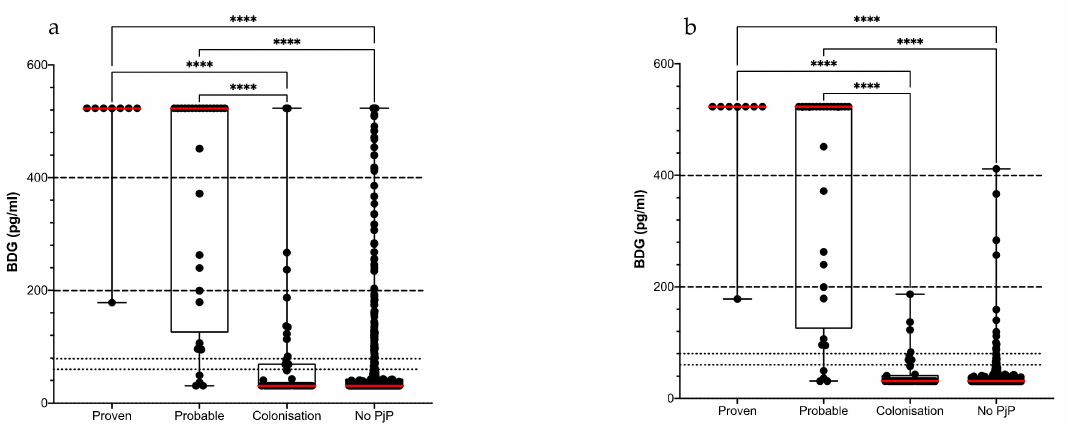
Figure 3. BDG value in 609 episodes from 575 HIV-negative patients suspected of PjP according to the final diagnosis retained. BDG values ( a ) with and ( b ) without evident cases of BDG false positive results. Comparison of the four groups was done using Kruskal-Wallis tests followed by Dunn’s pair-wise comparisons. p -adjusted values are indicated. Red line: median BDG value. **** p < 10 − 4 . Among the 573 episodes considered non-PjP or Pj colonization, 100 (17.5%), 50 (8.7%) and 32 (5.6%) episodes presented with a BDG value > 80 pg/mL, >200 pg/mL and >400 pg/mL, respectively, leading to a specificity ranging from 82.6% [95% CI: